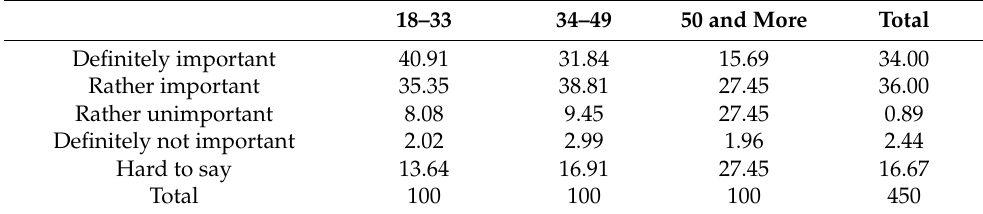
Table 5. Importance of acquiring new competences vs. age in % (N = 450).